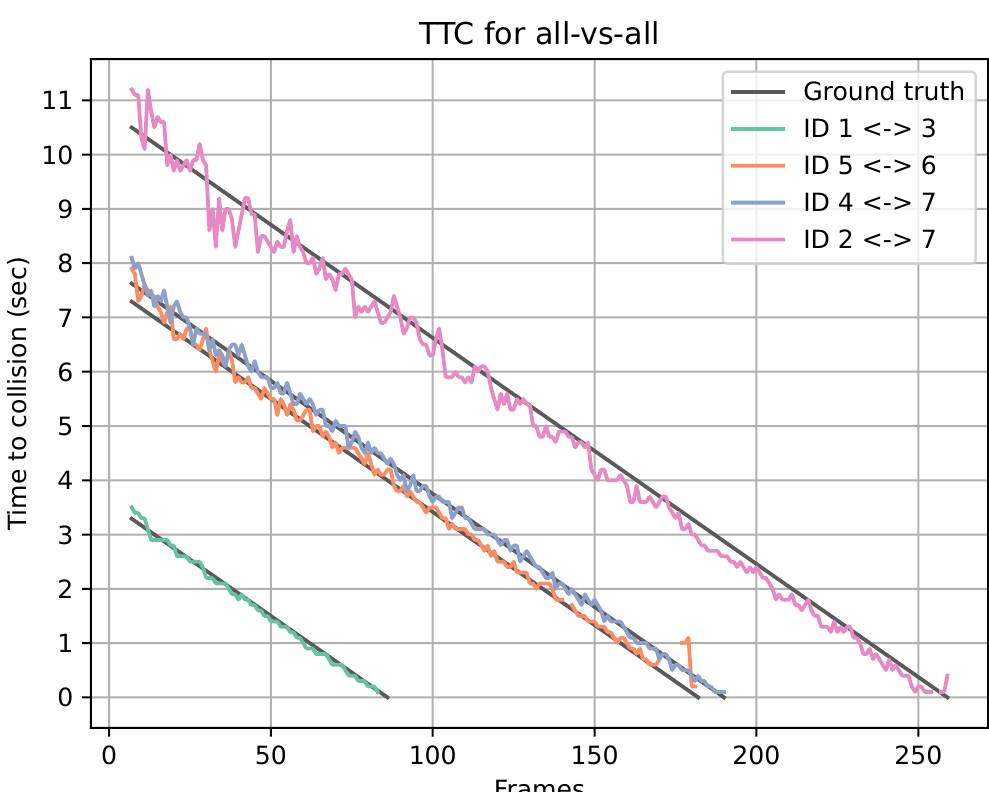
Figure 7. Predicted TTC for all four collisions from scenario 1, and corresponding ground truth